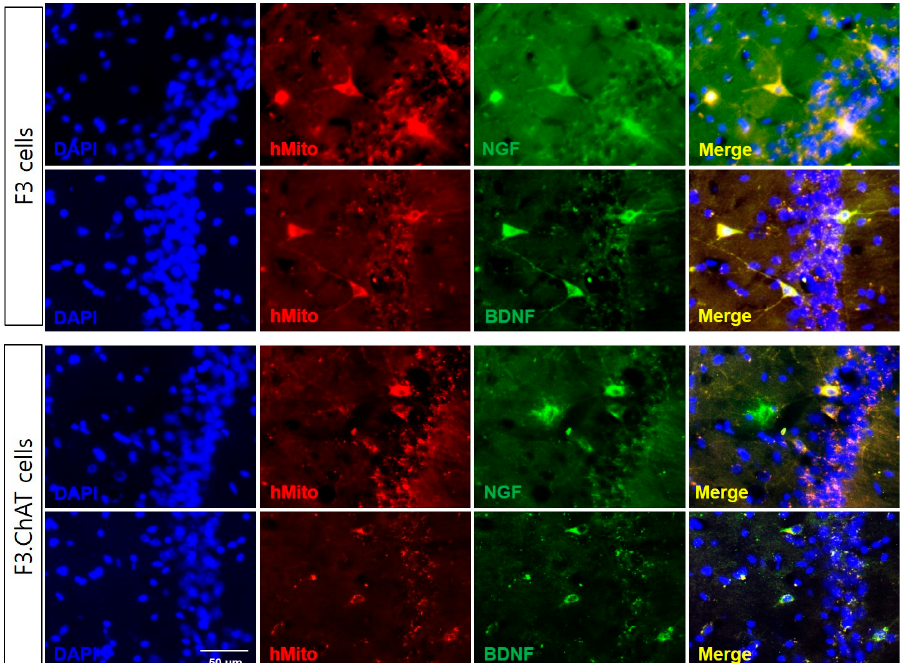
Figure 9. Representative immunohistochemical images indicating the expression of NGF and BDNF in F3 and F3.ChAT cells. Human mitochondria (hMito) was used as the transplanted F3 and F3.ChAT cell markers. Expression of NGF (Upper panel) and BDNF (Bottom panel) in the hippocampus of ovariectomized rat four weeks after transplantation of F3 and F3.ChAT cells were analyzed using double immunostating. Scale bar = 50 µ m, magnification ×